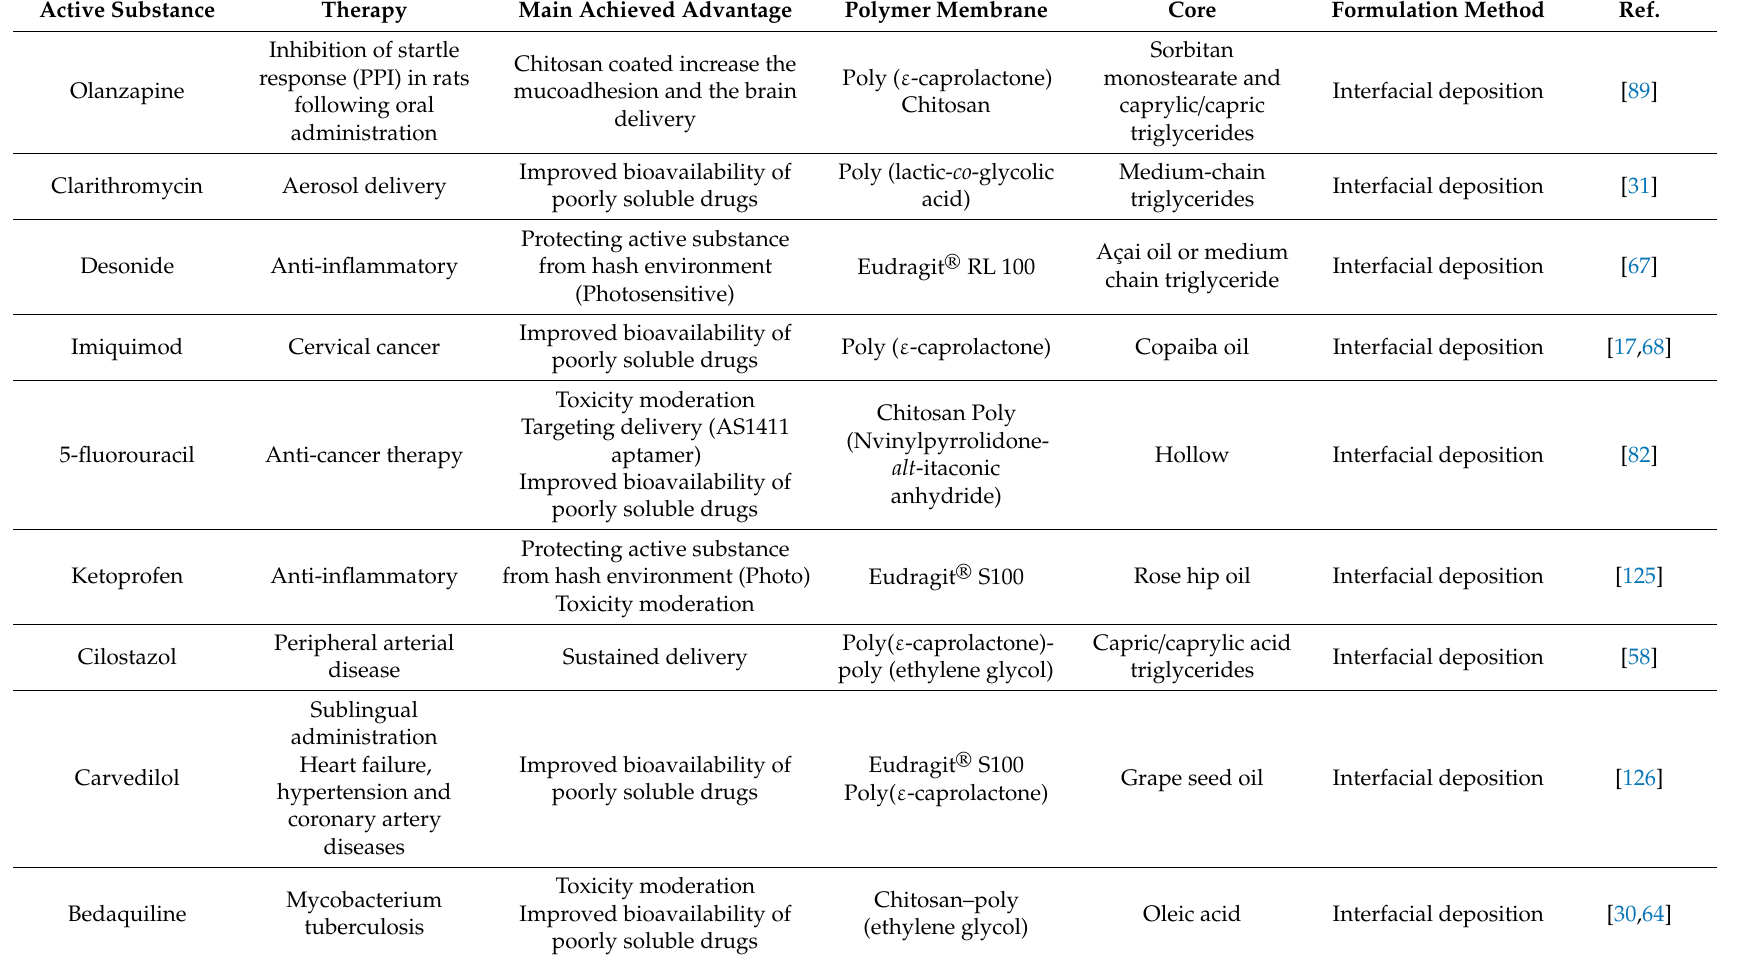
Table 6. Examples of polymeric nanocapsules applications as drug delivery system in recent